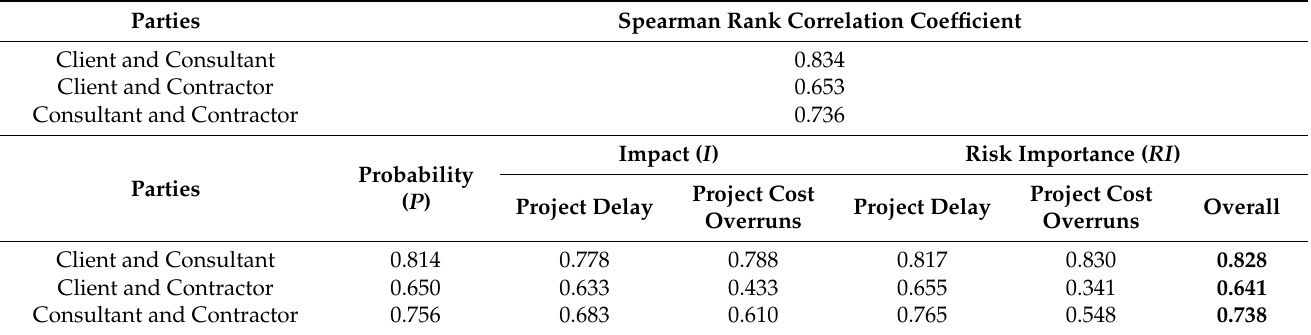
Table 6. Spearman’s rank correlation coefficient between parties